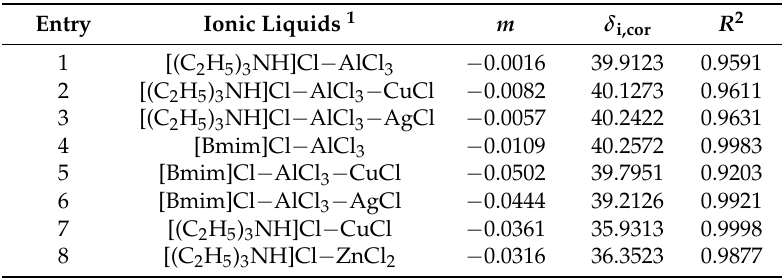
Table 1. Parameters of linear regression for various ionic